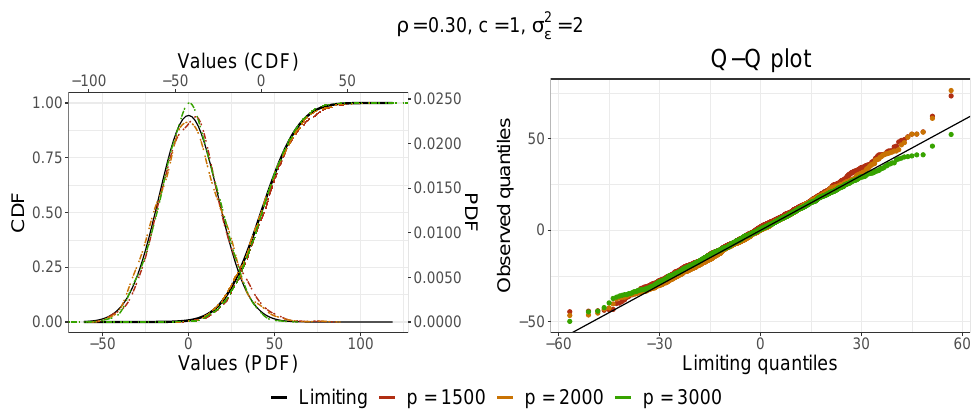
Figure 2. Comparison of the PDF and CDF ( left ) and the corresponding Q-Q plots ( right ) after 1000 replications from the Monte Carlo simulation of the statistic (80) with the limiting distribution N ( 0, s 2 ) by the Corollary 2 (in black) for (cid:36) = 0.3, c = 1, σ 2 = 2 and p = 1500,2000,3000. ε